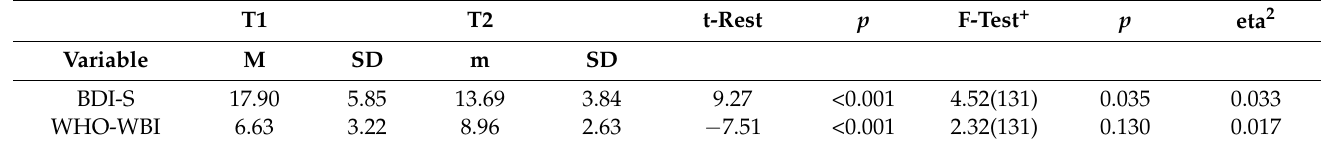
Table 3. Comparison of variables included in the intervention outcome-monitoring